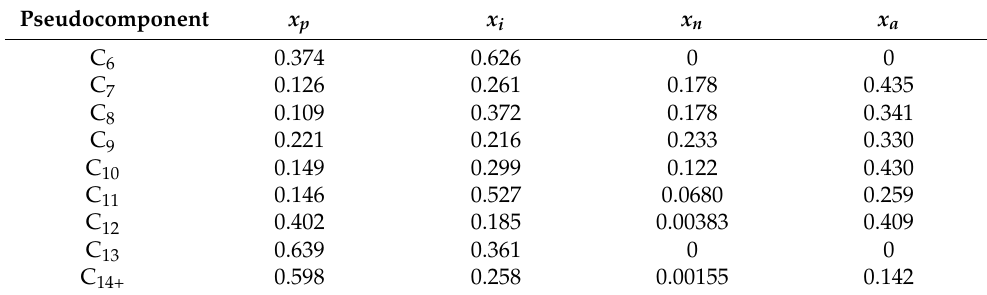
Table 11. Average PINA distribution for each pseudocomponent for the average gas type. The mole fractions of paraffins, isoparaffins, naphthenics and aromatics are denoted x p , x i , x n and x a , respectively.